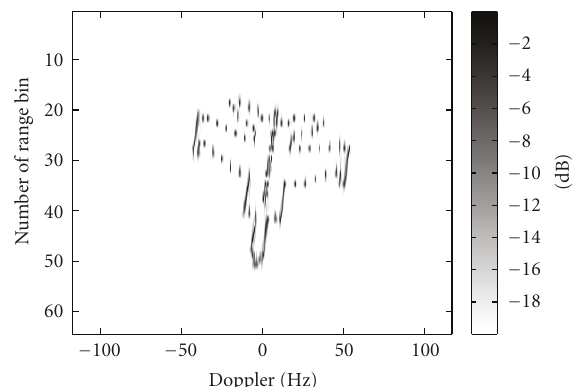
Figure 9: ISAR image after compensating the motion (simulated